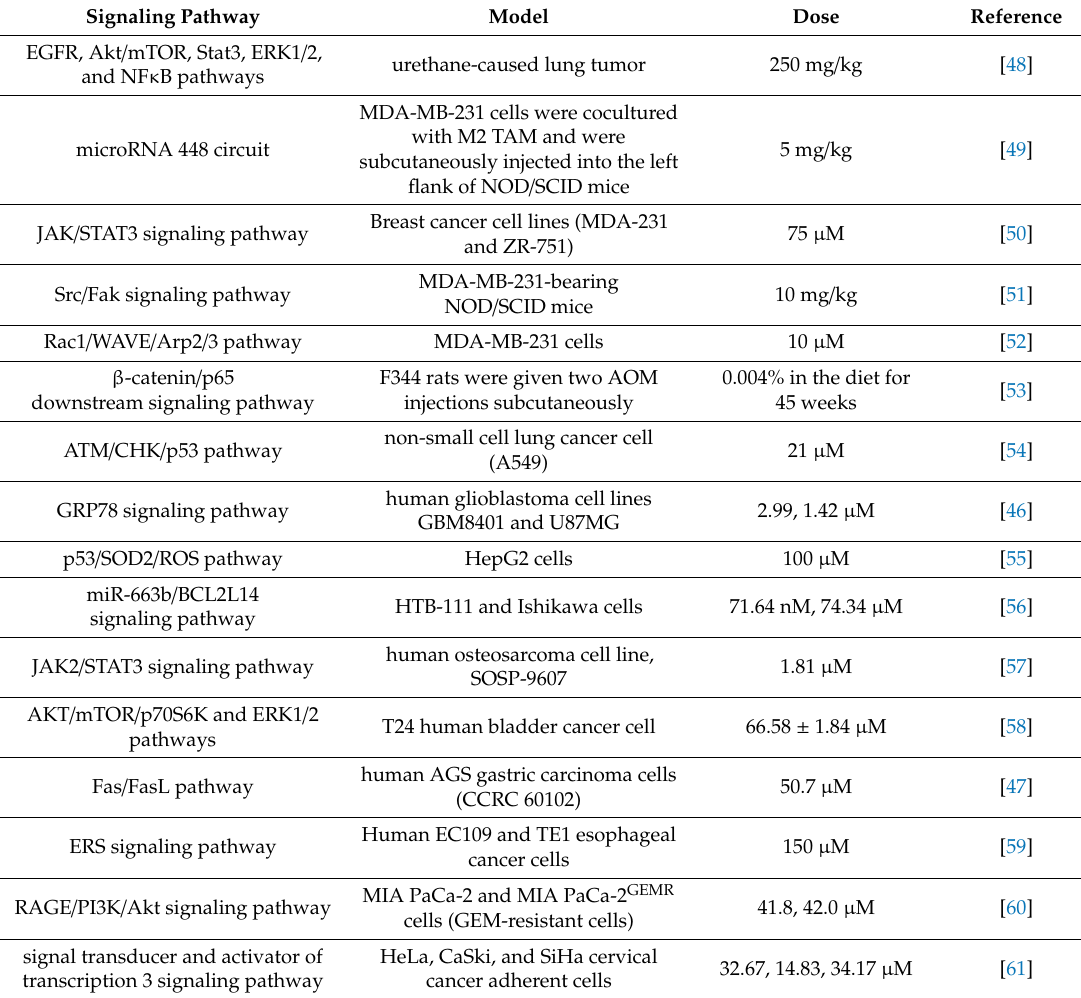
Table 2. Signaling pathway of the anti-tumor e ff ect of